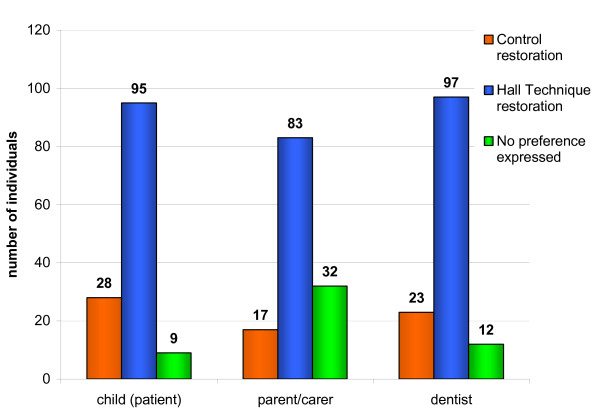
Patient/carer/dentist treatment preference (n = 396 for 132 treatment events).